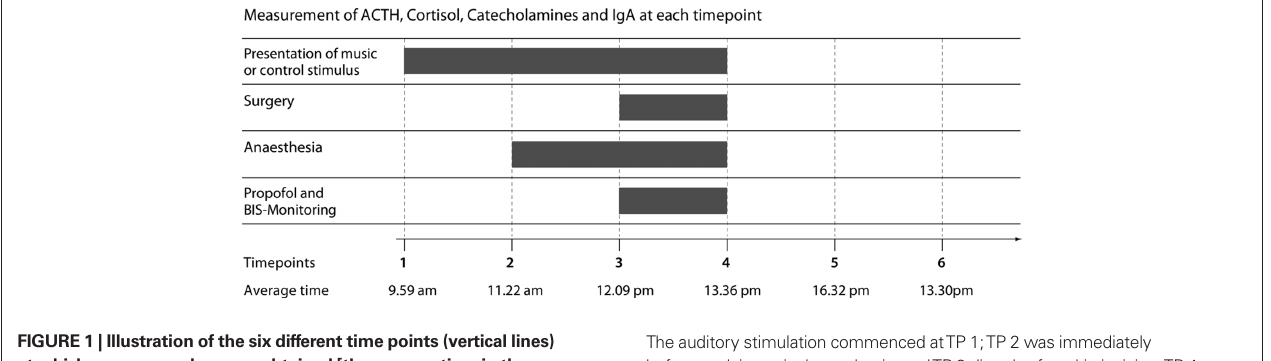
The auditory stimulation commenced at TP 1; TP 2 was immediately before applying spinal anesthesia, and TP 3 directly after skin incision. TP 4 was before skin closure; TP 5 was 3 h, and TP 6 was 24 h, after the end